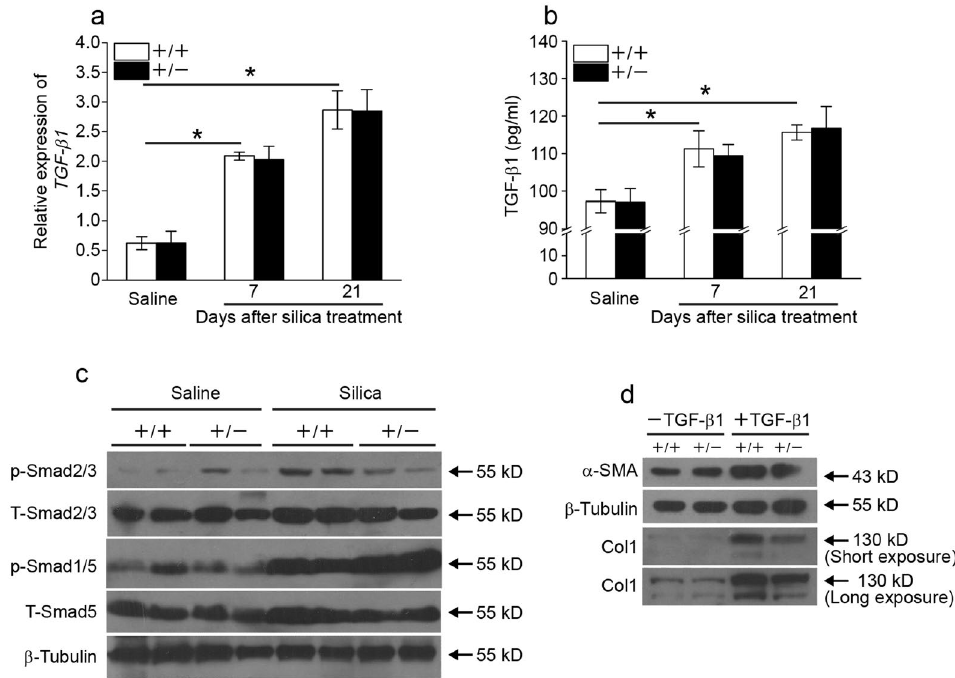
Figure 5. Fstl1 modulates myofibroblast differentiation via facilitating TGF- β 1 signaling. ( a ) qRT-PCR analysis of TGF- β 1 mRNA expression in lung tissues of Fstl1 + / − and WT mice at indicated time after saline or silica exposure (n = 4 per group; * P < 0.05 by one-way ANOVA followed by Student’s t test). ( b ) ELISA analysis of active form of TGF- β 1 protein in lung tissues of Fstl1 + / − and WT mice at indicated time after saline or silica exposure (n = 4 per group; * P < 0.05 by one-way ANOVA followed by Student’s t test). ( c ) The levels of phosphorylation of Smad2/3 (p-Smad2/3), total Smad2/3 (T-Smad2/3), phosphorylation of Smad1/5 (p-Smad1/5) and total Smad1/5 (T-Smad1/5) in lung tissues of of Fstl1 + / − and WT mice 21 days after saline or silica exposure were determined by western blot analysis. β -tubulin was used as a loading control. ( d ) Primary lung fibroblasts from Fstl1 + / − and WT mice were treated with 5 ng/ml TGF- β 1. Protein expressions of α -SMA in cell extracts and type I collagen (Col1) in medium 24 h after TGF- β 1 treatment were determined by western blot analysis. β -tubulin was used as a loading